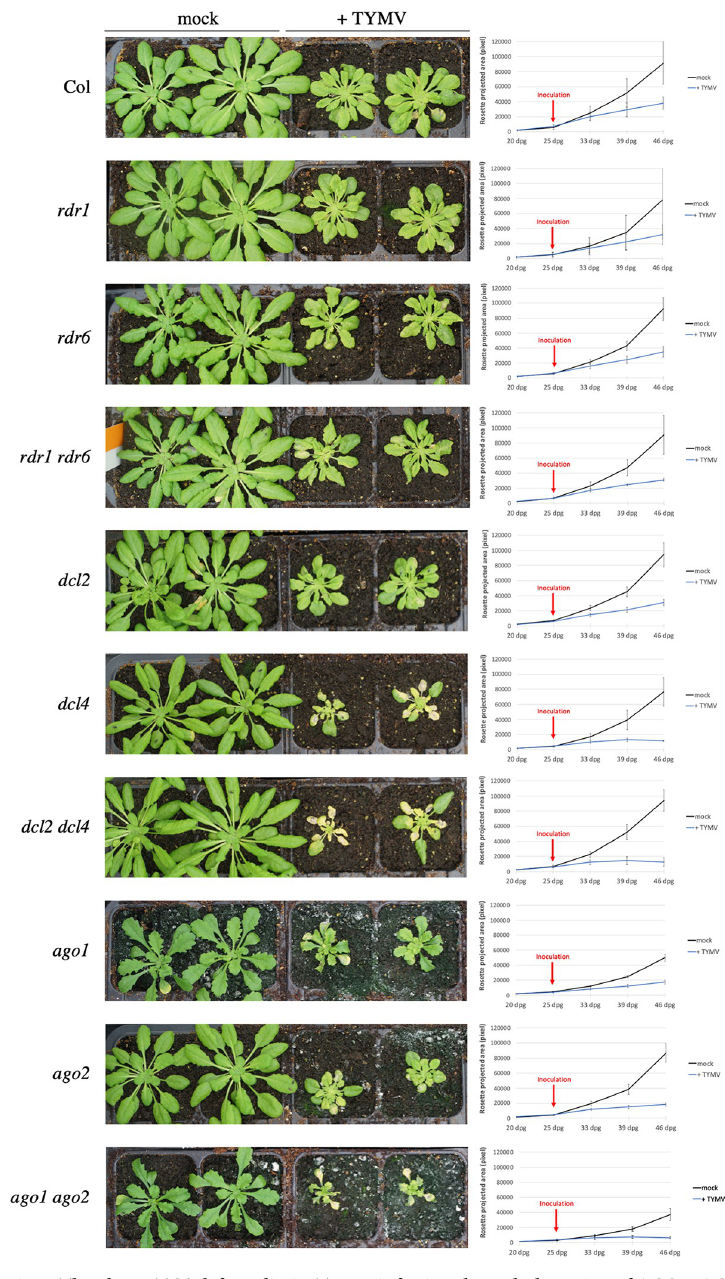
Fig 1. The plant PTGS defense limits TYMV infection through the action of AGO1, AGO2 and DCL4. Pictures of mock- and TYMV-infected plants of the indicated genotypes three weeks after infection with TYMV. Plants were grown under short day conditions. The growth curves show the temporal change of rosette area (averaged by four plants, +/-SE) in mock- and TYMV-infected plants from one week pre-inoculation to three weeks post-inoculation. dpg: days